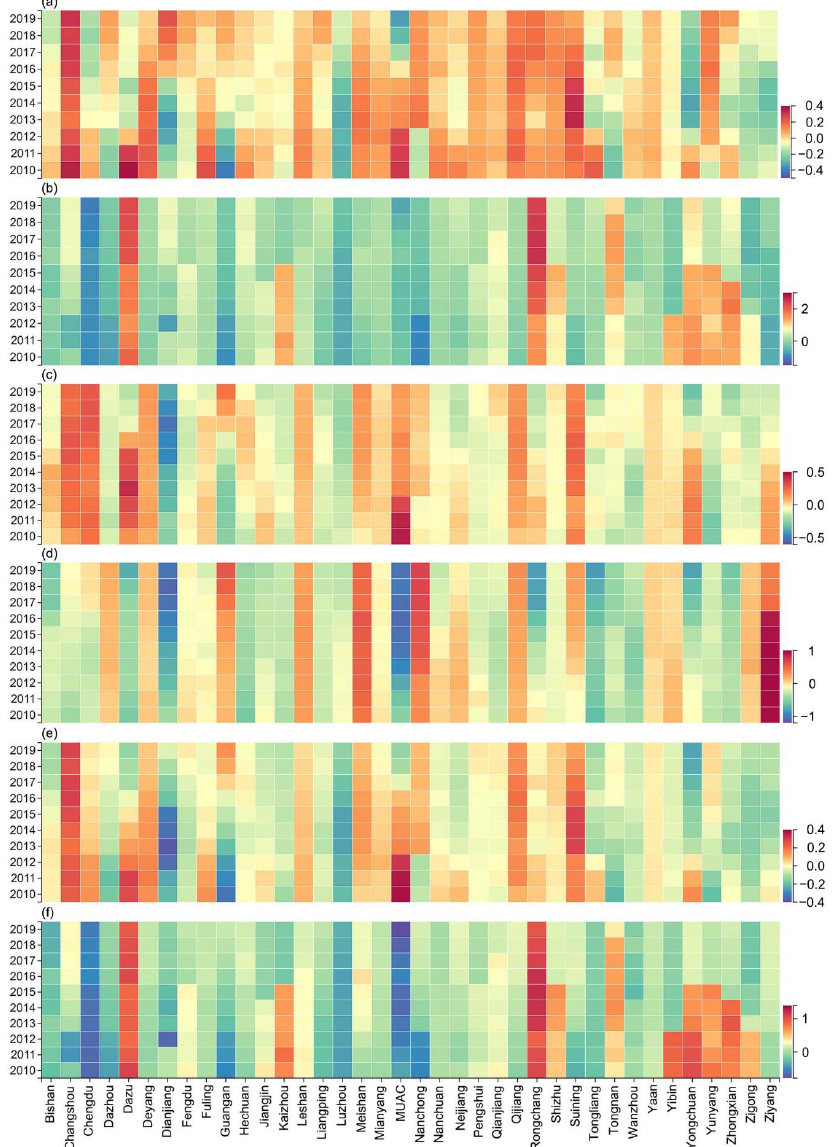
Figure 9. DEP from 2010 to 2019. ( a – f ), respectively, represent the changes of equilibrium in full-time primary school teachers, the number of primary schools, full-time middle school teachers, the number of middle schools, full-time PMS teachers, and the number of